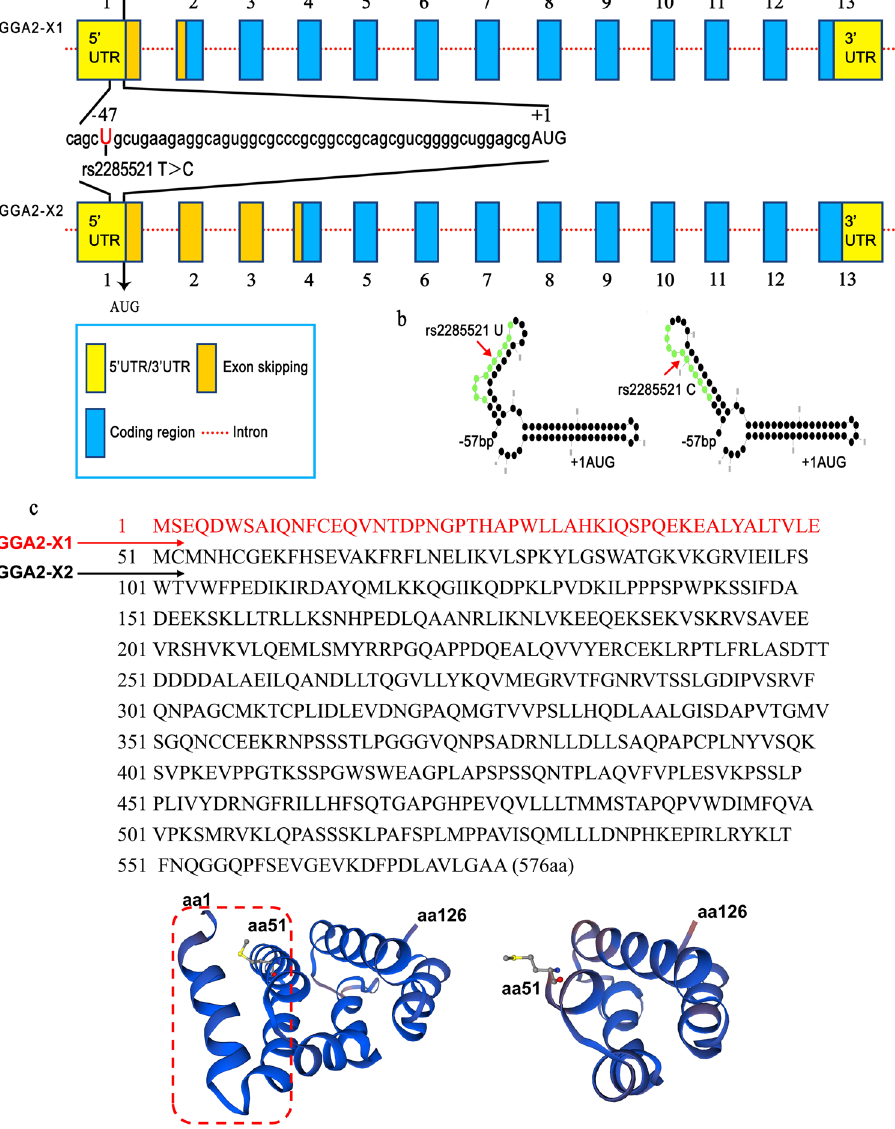
Fig. 4 Diagram representation of the alternative splicing pattern of GGA2 transcripts and the amino acid (aa) sequence, protein structures, and domains of the GGA2-isoforms. a Results of SNP rs2285521 sequencing in the 53 bp sequence of 5 ’ UTR region in Exon 1 of the GGA2 : Genomic structure of the GGA2-X1 and GGA2-X2 . Splicing pattern of the GGA2 variant with SNP rs2285521 T>C. The position of the A nucleotide in the start codon (ATG) is de fi ned as + 1. b Part of RNA secondary structure of the GGA2 rs2285521 U and GGA2 rs2285521 C. c The aa sequence of GGA2-X1 and GGA2-X2. The GGA2-X1 isoform encodes a 576 aa protein and GGA2-X2 encodes a 526 aa protein. The aa sequence of red is where GGA2-X2 starts. d Part of the secondary structures and domains of putative isoforms of GGA2-X1 and GGA2-X2. aa1- aa50 circled by red was the part two isoforms